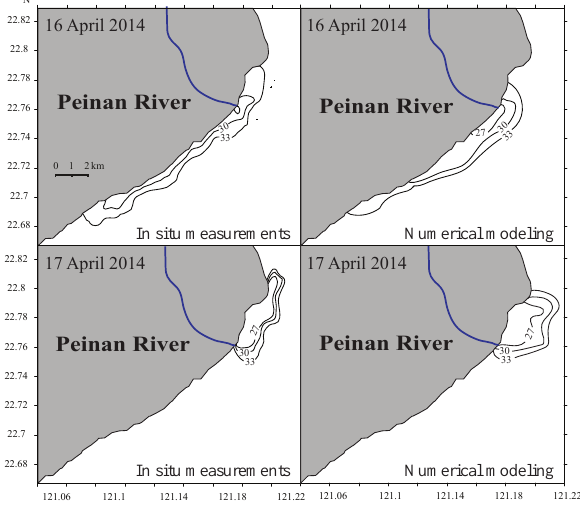
Figure 4. Surface salinity distribution (27, 30, and 33PSU isolines), illustrating deposition and internal structure of the Peinan River plume obtained from the in situ measurements (left panels) and sim- ulated by the numerical model (right panels) on 16 April 2014 (top panels) and 17 April 2014 (bottom